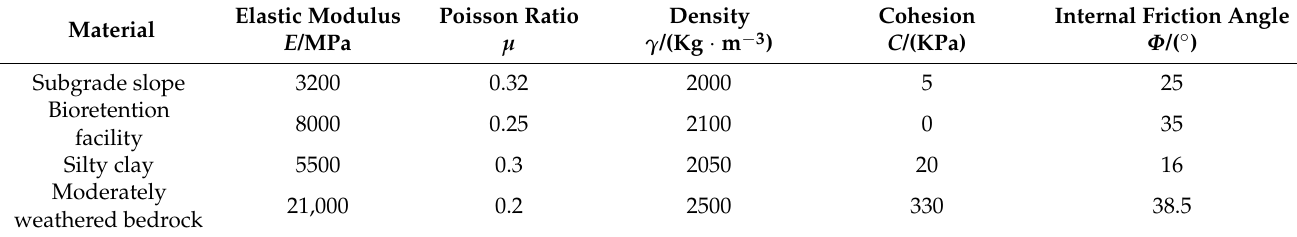
Table 1. Mechanical parameters.